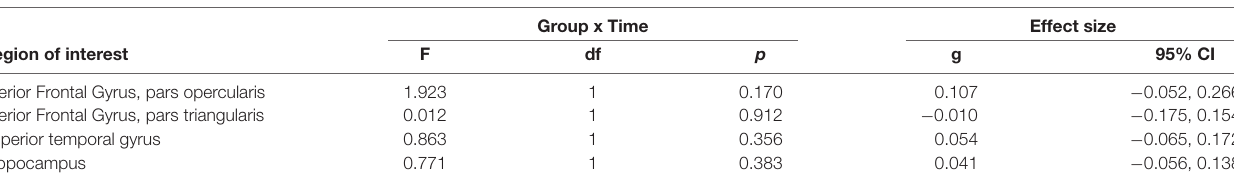
TABLE 2 | Interaction effect of group and time on gray matter in regions of interest.